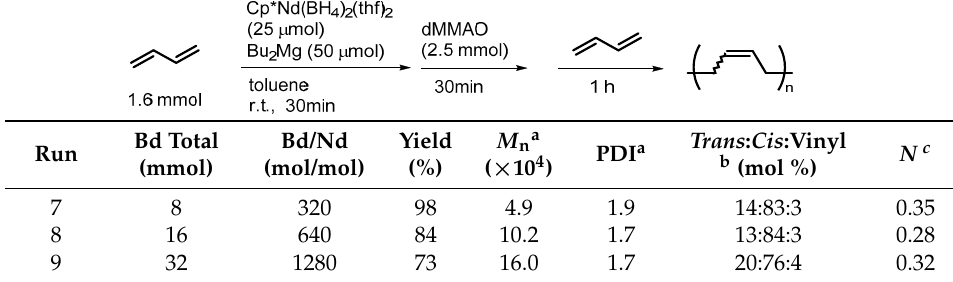
Run Bd Total (mmol)